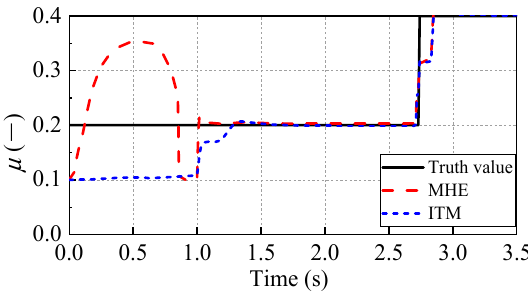
Figure 20. A partially enlarged view of the estimation RFC.